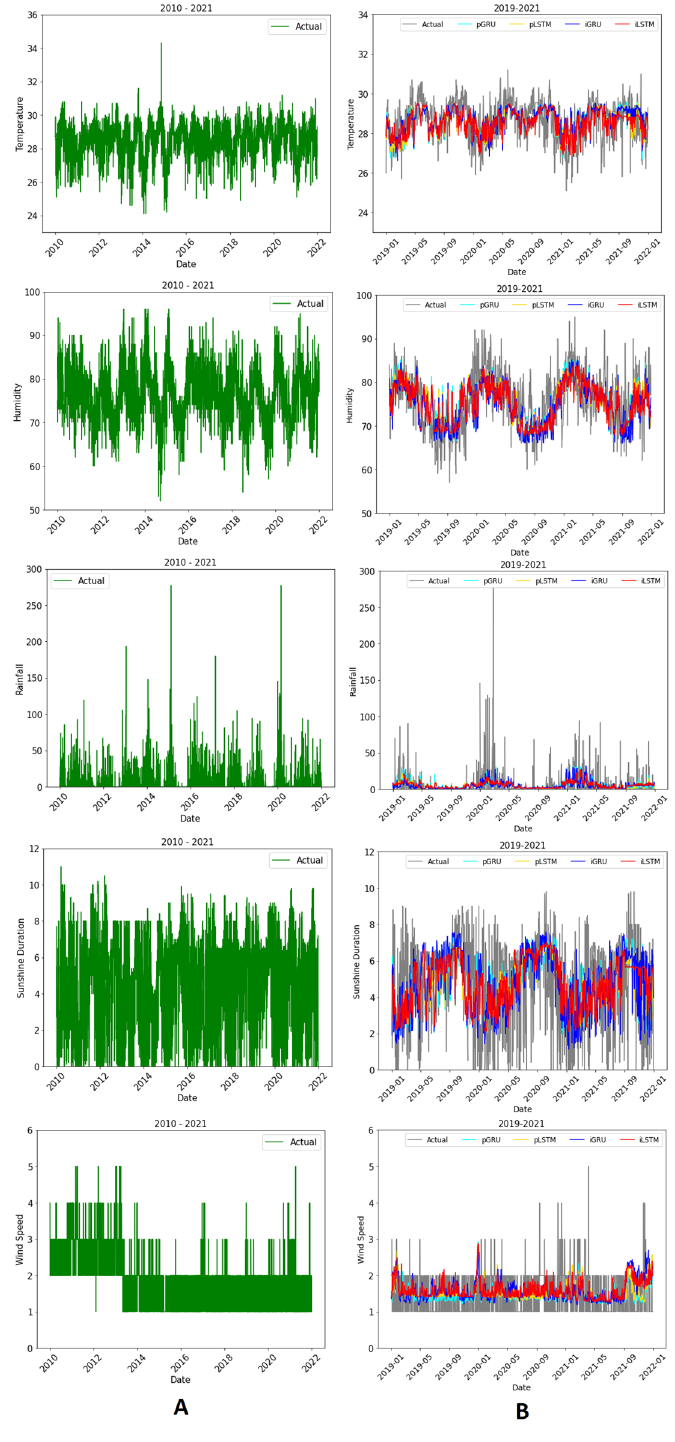
Figure 5. The actual data ( A ) and forecasting ( B ) of meteorological condition in